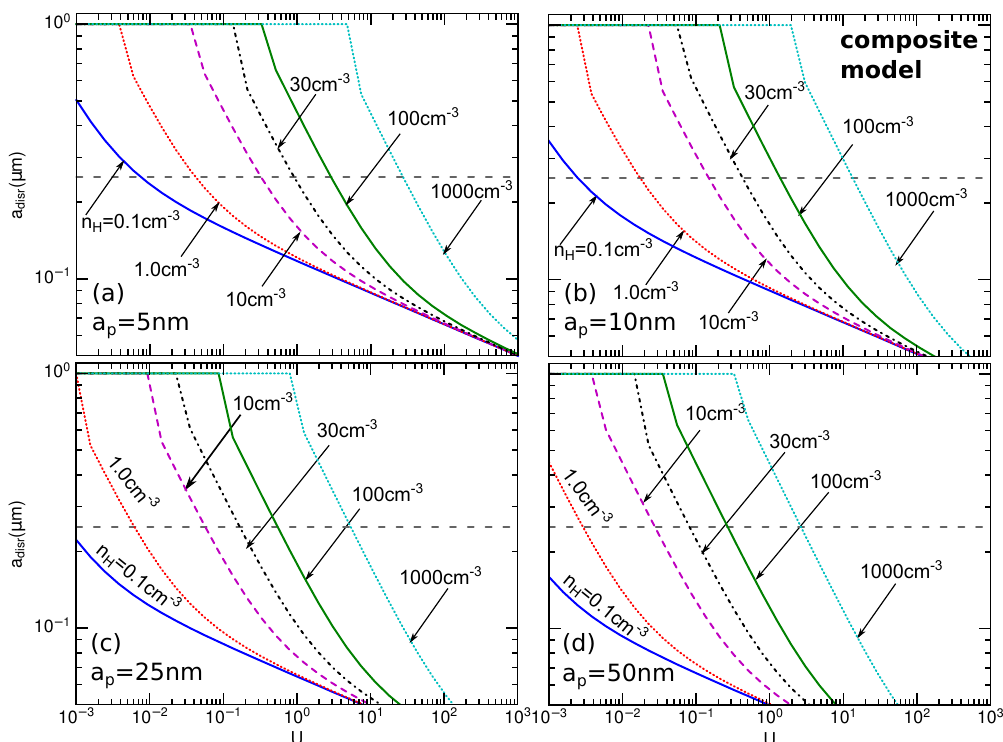
Figure 15. Disruption grain size as a function of the radiation strength, U , for a composite grain model with porosity P = 0.2 for the different gas density n H , assuming a p = 5,10,25 and 50 nm (panels (a)–(d)). The horizontal dashed line marks the upper limit of the MRN size distribution a max = 0.25 µ m. We set a disr = 1.0 µ m in case of no disruption. The disruption size decreases with increasing U due to stronger RATs, but it increases with increasing n H due to the increase of rotational damping. Rotational disruption is more efficient for larger a p (panel (d)) due to lower tensile strength (see Equation (41)). From Hoang [34].